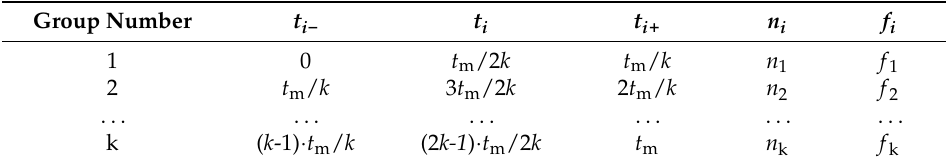
Table 1. Reliability data acquiring and